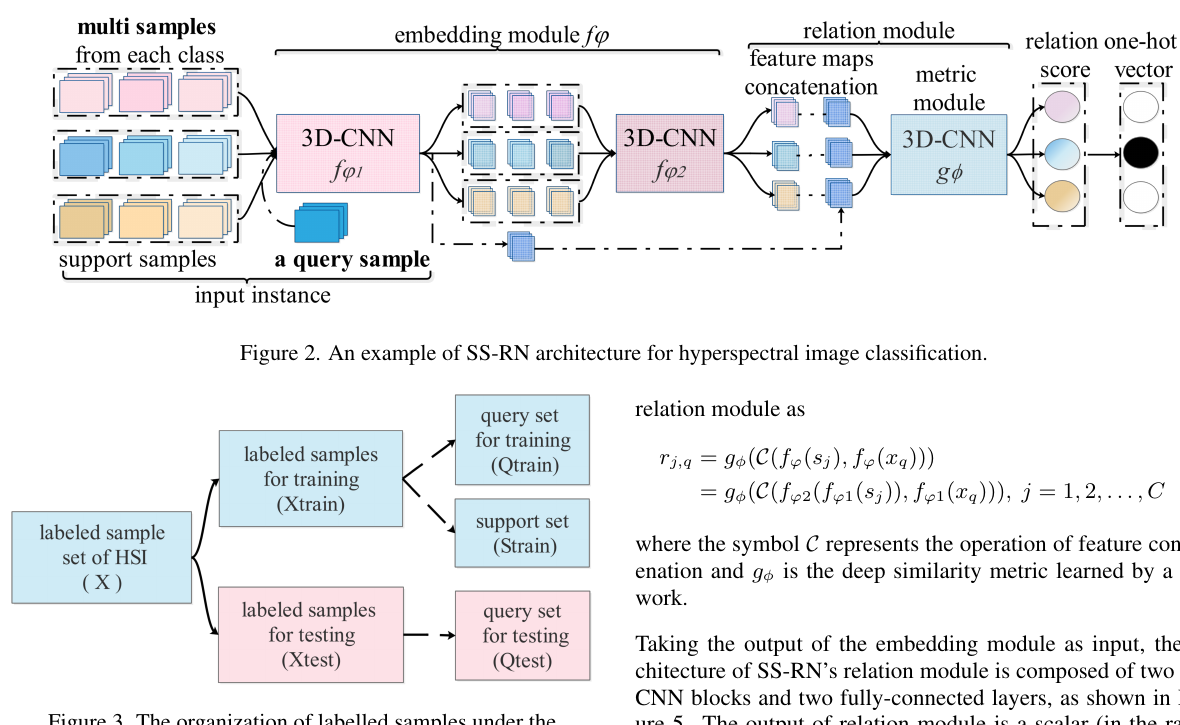
Figure 1. Illustration of ortho-waveforms (blue curves) computed from raw data (top-left and star points) for 5 spatial points.